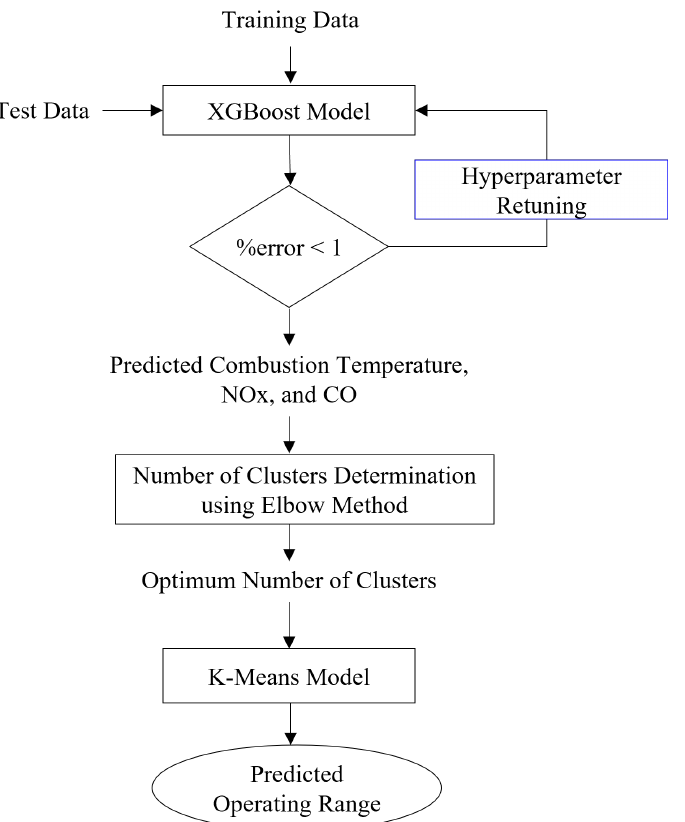
Figure 2. Flowchart of model